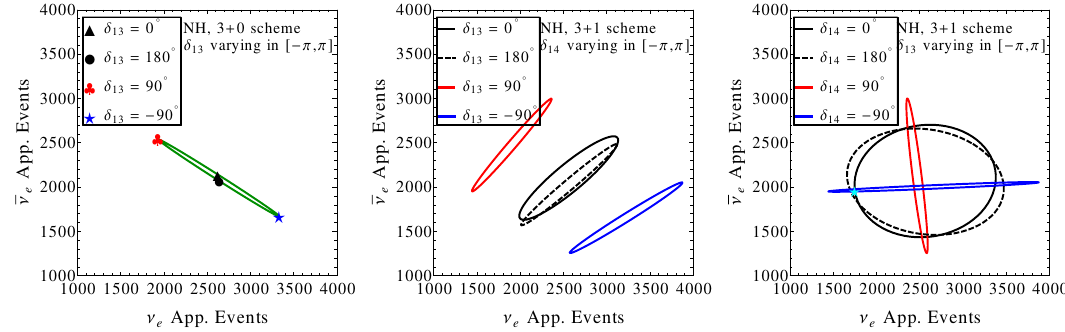
Figure 3 . Bievents plots for the 3-(cid:13)avor framework (left panel) and 3+1 scheme (central and right panels). In the left panel two black marks are located for the test cases of no CPV ( (cid:14) 13 = 0 ; (cid:25) ) and two colored ones for the true cases corresponding to maximal CPV ( (cid:14) 13 = (cid:0) (cid:25)= 2 ; (cid:25)= 2). For completeness we draw also the (green) ellipse where the 3-(cid:13)avor model lives, which is obtained by varying (cid:14) 13 in the range [ (cid:0) (cid:25); (cid:25) ]. The non-zero distance between the black marks and the colored ones indicates that events counting can determine CPV induced by the phase (cid:14) 13 in the 3 (cid:23) case. In the 3+1 scheme a (cid:12)xed value of (cid:14) 13 is represented by an ellipse, where (cid:14) 14 varies in the range [ (cid:0) (cid:25); (cid:25) ]. The non-zero minimal distance between the black ellipses and each of the two colored ones indicates that events counting is sensitive to CPV induced by the phase (cid:14) 13 also in the 3+1 case. The right panel illustrates the sensitivity to the CPV induced by (cid:14) 14 . In this case four ellipses are plotted for four (cid:12)xed values of (cid:14) 14 (while (cid:14) 13 is varying in the range [ (cid:0) (cid:25); (cid:25) ]). Each of the two ellipses (blue and red) corresponding to maximal CPV induced by (cid:14) 14 crosses the two ellipses (solid and dashed black) corresponding to no CPV induced by (cid:14) 14 . In the (unlucky) crossing points the events counting is not sensitive to CPV induced by the new CP-phase (cid:14) 14 . See the text for